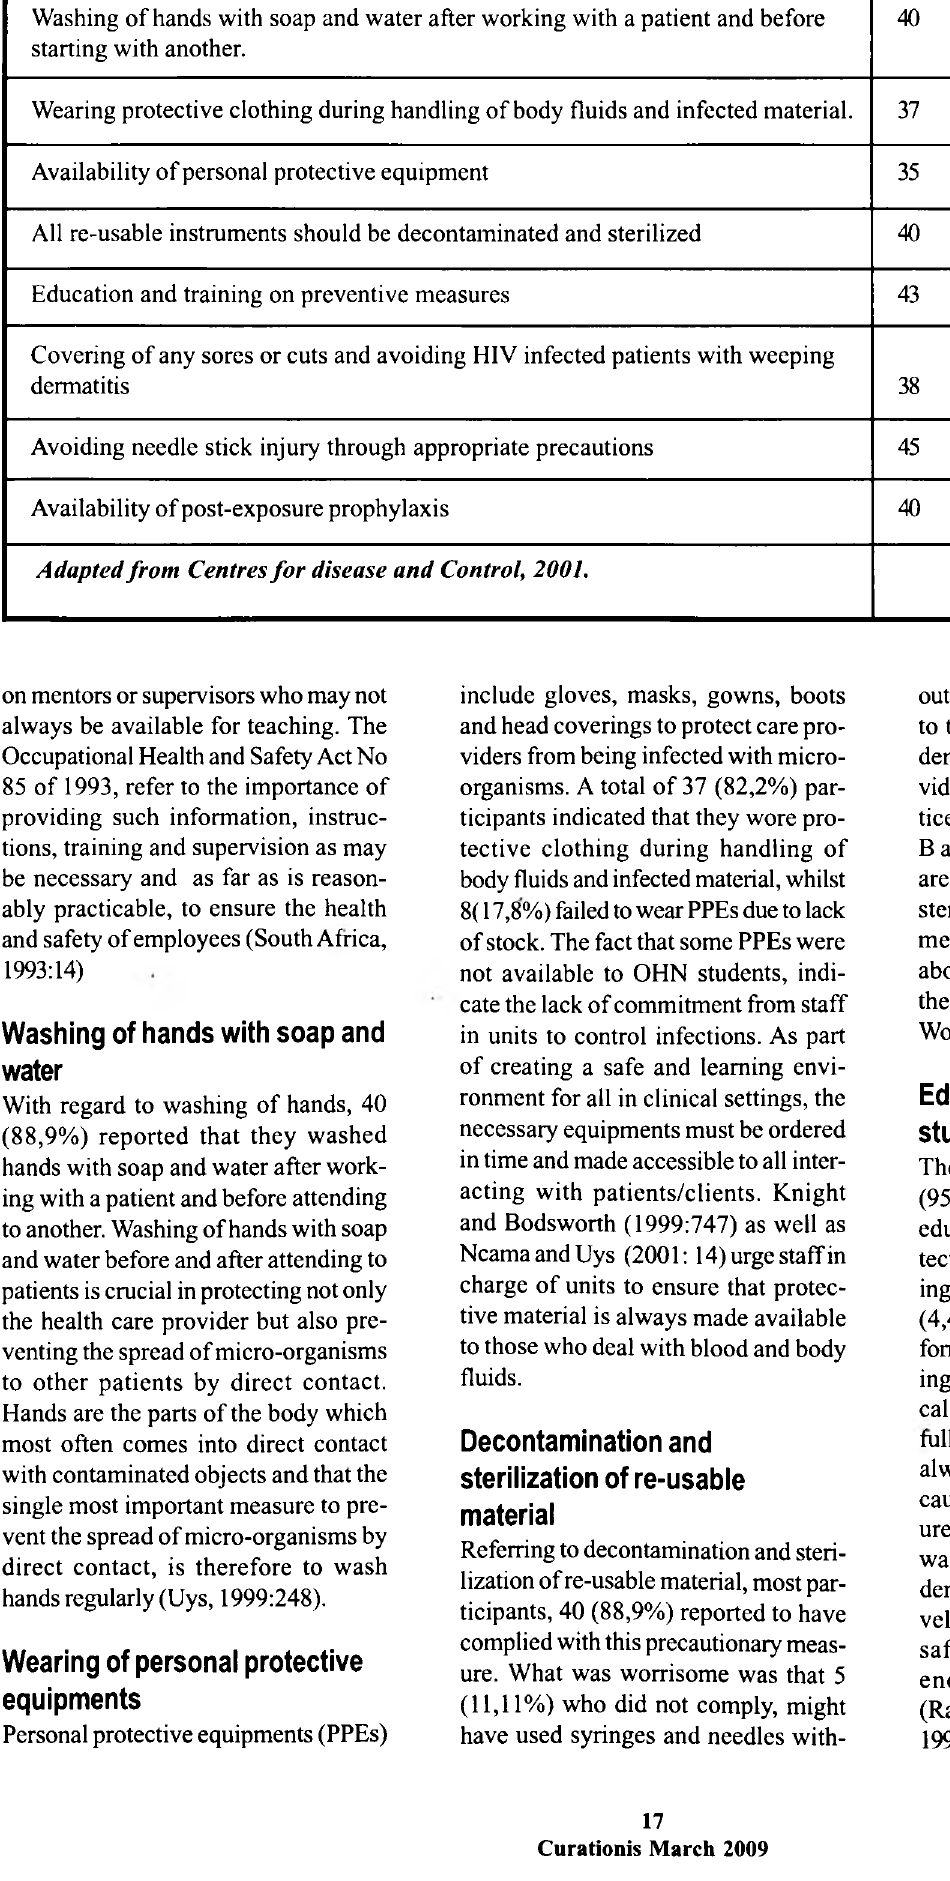
Compliance with precautionary measures Frequency Percentage Washing of hands with soap and water after working with a patient and before starting with another. Wearing protective clothing during handling of body fluids and infected